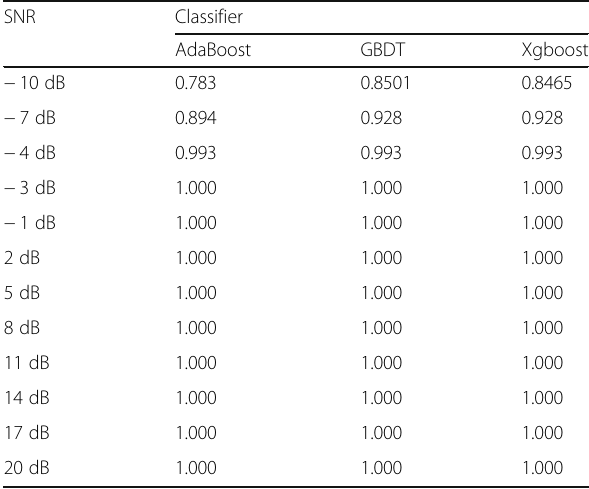
Table 1 Probability of different ensemble learning